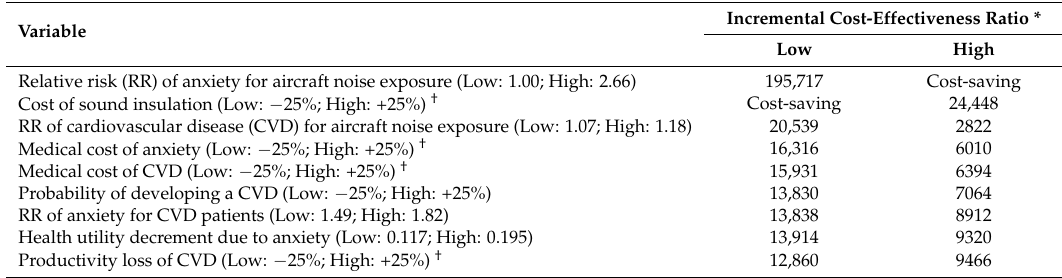
Table 3. One-way sensitivity analyses of the cost-effectiveness of changing the regulatory day–night average sound level (DNL) from 65 decibels (dB) to 55 dB versus the status quo.